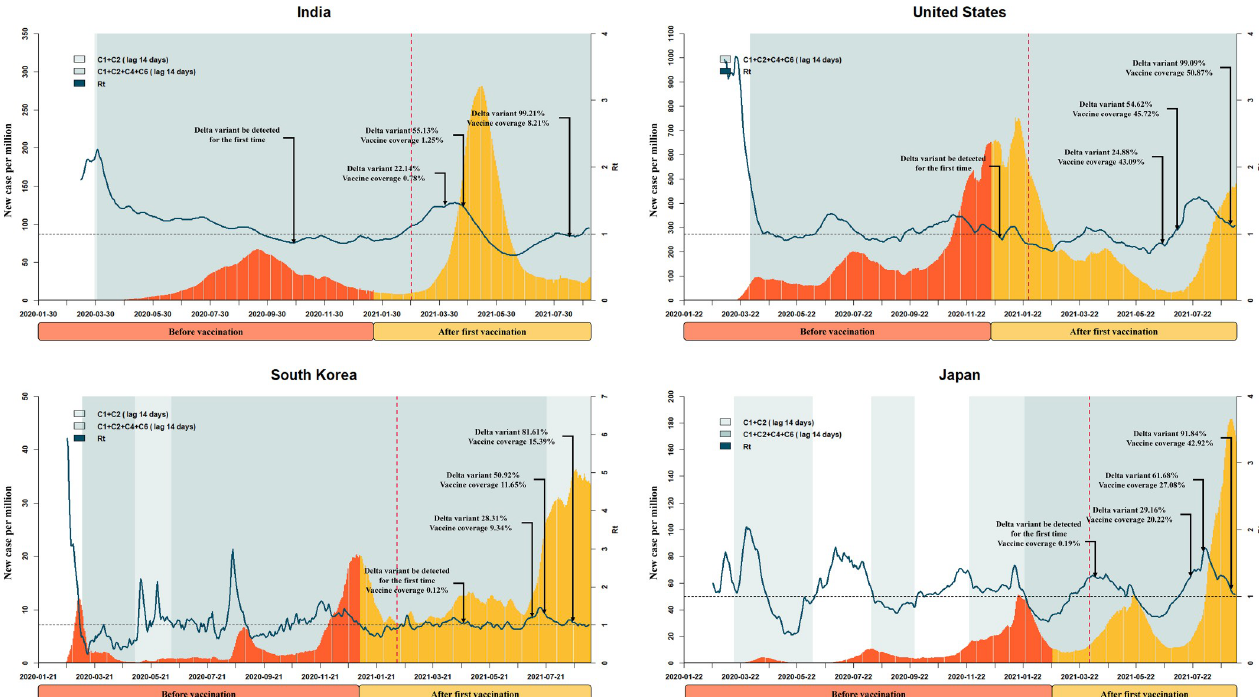
Fig 2. Key events during the progression of the pandemic in India, United States, South Korea and Japan. The x axis represents time. The y axis represents daily new confirmed cases. The fluctuation line represents the effective reproductive number (R t ). The shading represents the implementation of a public health measure plus 14 days (lag time). The light-to-dark color shift indicates an increase of stringency. The dotted vertical line represents the announcement of vaccination plus 40 days (lag time). Some key proportions of Delta variant and vaccine coverage are marked using dark arrows.